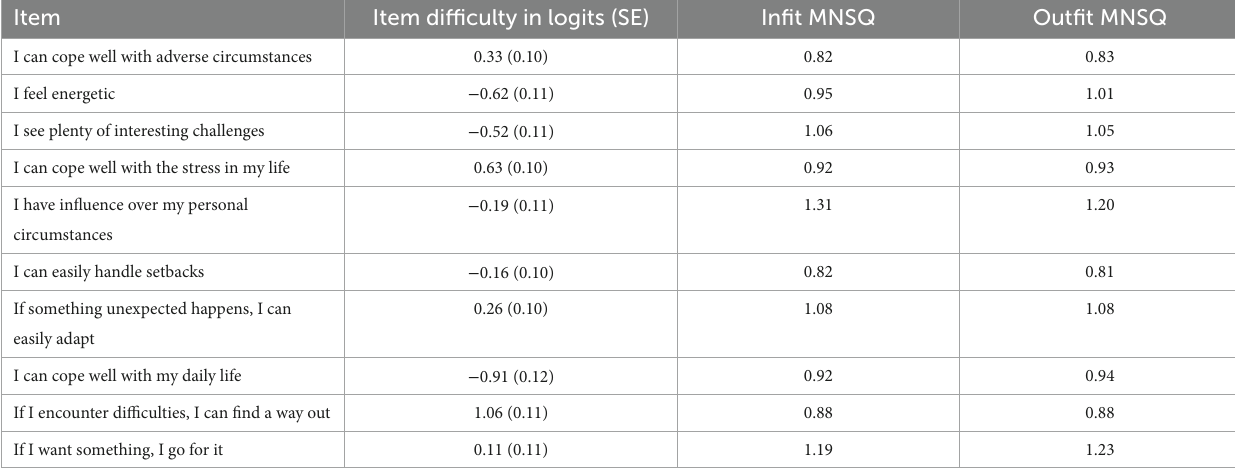
TABLE 2 Rasch analysis results of the final 10 items of the